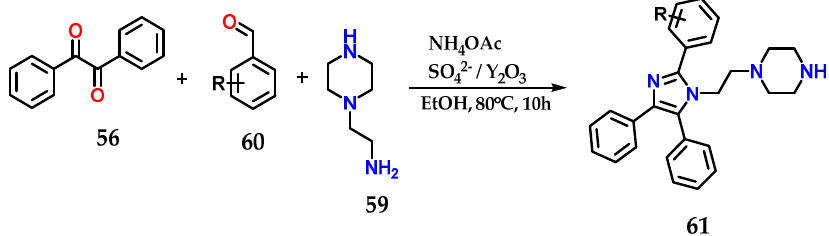
Figure 24. Tetrasubstituted imidazoles 61 were obtained from the multicomponent condensation of benzyl 56 , aminoethylpiperazine 59 , various aldehydes 60 and ammonium acetate using SO 42− /Y 2 O 3 as a catalyst.